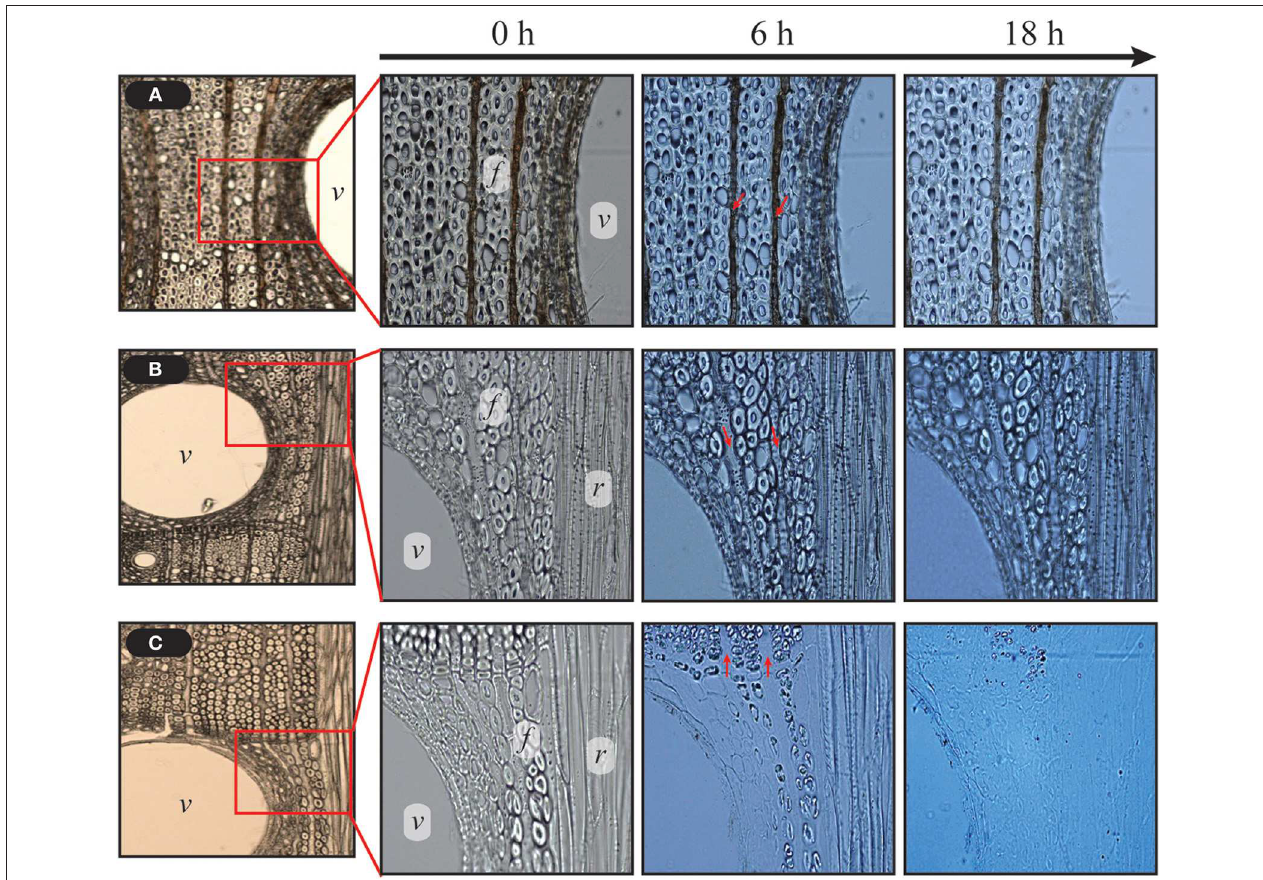
FIGURE 3 | Comparison of hydrolysis rate between HPAC and ASC pretreatment. The control and delignified samples were incubated with 15 FPU cellulase g − 1 biomass (50 µ L mL − 1 cellulase) at 50 ◦ C. HPAC-treated oak was completely hydrolyzed for 18h. Uniseriate ray parenchyma cells (indicated by red arrows) were hydrolyzed faster than wood fibers at 6h ( c ). v , vessel elements; f , fibers including wood fibers and tracheids; r , broad ray.